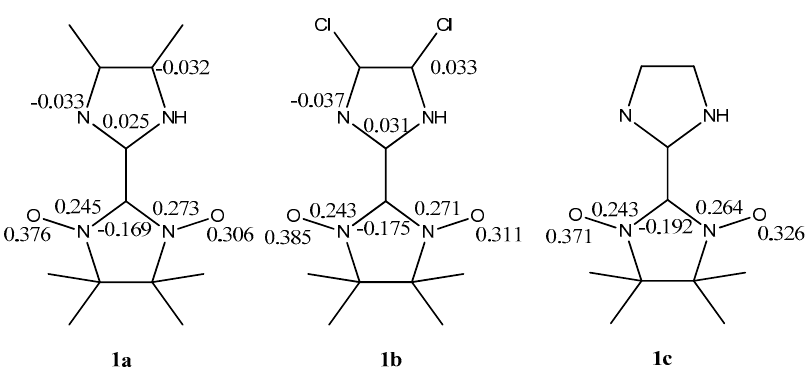
Figure 5. Mulliken atomic spin densities calculated at the UB3LYP/def2-TZVP level of theory for